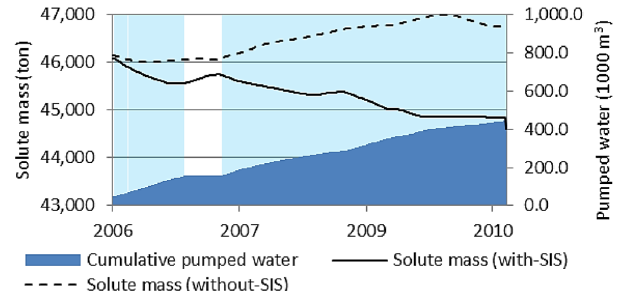
Fig. 13. Solute mass stored in the system in each time step for the defined scenarios. Cumulative pumped water is also shown in dark blue, and light blue pattern refers to the period that the pumps were in